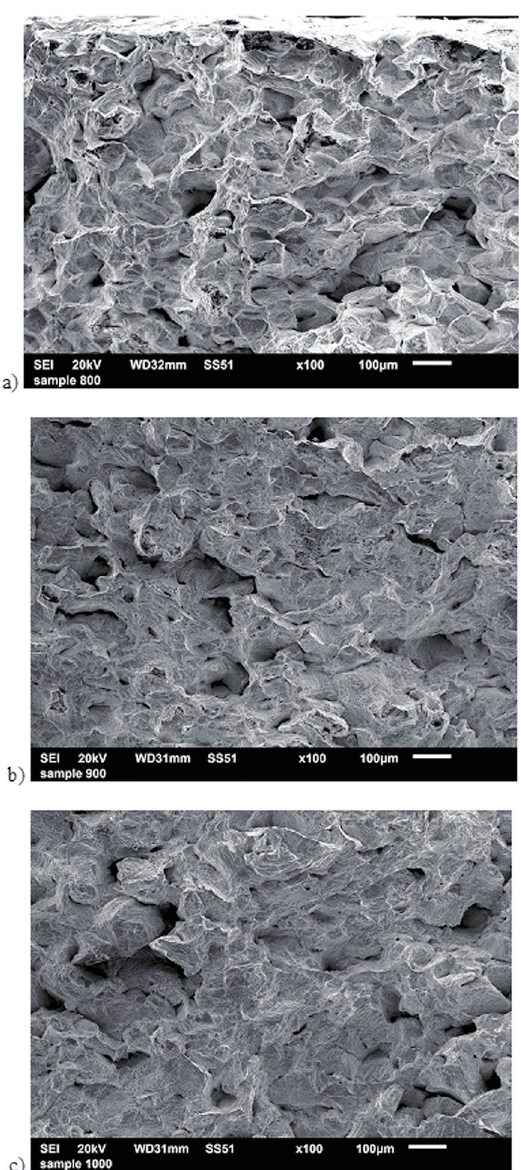
Figure 4: Examples of intercrystalline fracture at a) 800, b) 900 and c) 1000 °C for PtRh20Pd10Ir0.1Au0.1 alloy impact of impurities, such as Si and P in the investigated platinum alloys. Bismuth can somewhat neutralize the negative impact and accumulation of impurities such as Fe, Cu, Cr, Co, As and Ni. The most severe form is the presence of impurities with approximate values of the divergency range, and of the same sign, such as Al and Ag as a pair, and Zn and Si as a second pair. In these cases probability of equilibrium segregation of each pair of impurities increases, as well as their negative impact on the technological and exploitation properties of platinum